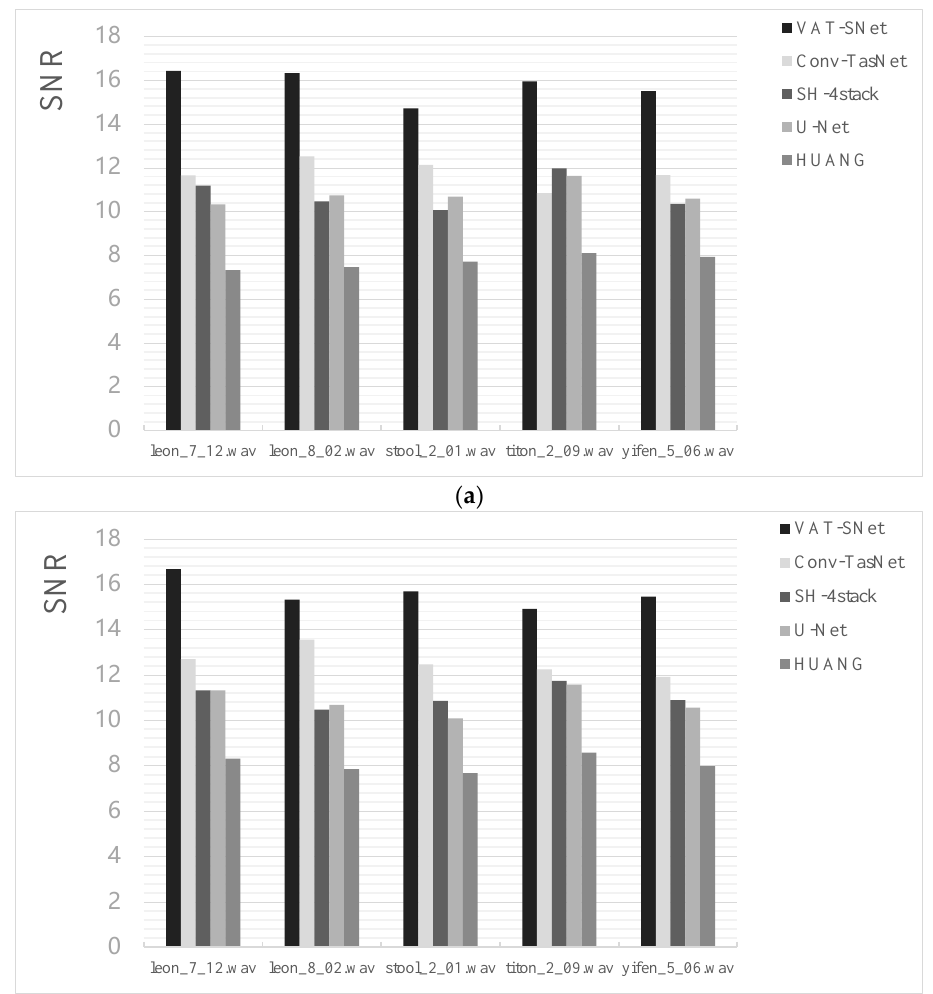
Figure 8. Comparison chart of the separation performance indexes of five random songs. ( a ) SNR(dB) of vocal separation contrast diagram; ( b ) SNR(dB) of accompaniment separation contrast diagram.